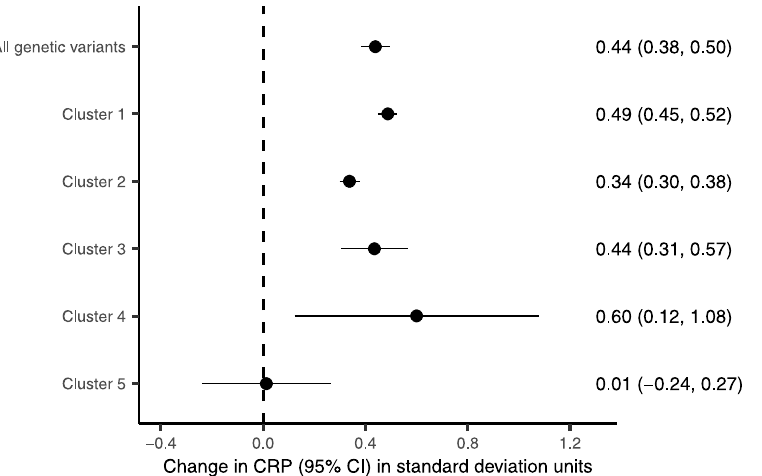
Fig 6. Results from the Mendelian randomization analyses of the effect of BMI on CRP. MR-IVW estimates and 95% confidence intervals of the association of genetically predicted BMI with CRP, for all genetic variants and for each cluster. The estimates represent the change in CRP in standard deviation units per 1 standard deviation increase in genetically predicted BMI. The dotted line indicates no association between genetically predicted levels of CRP and